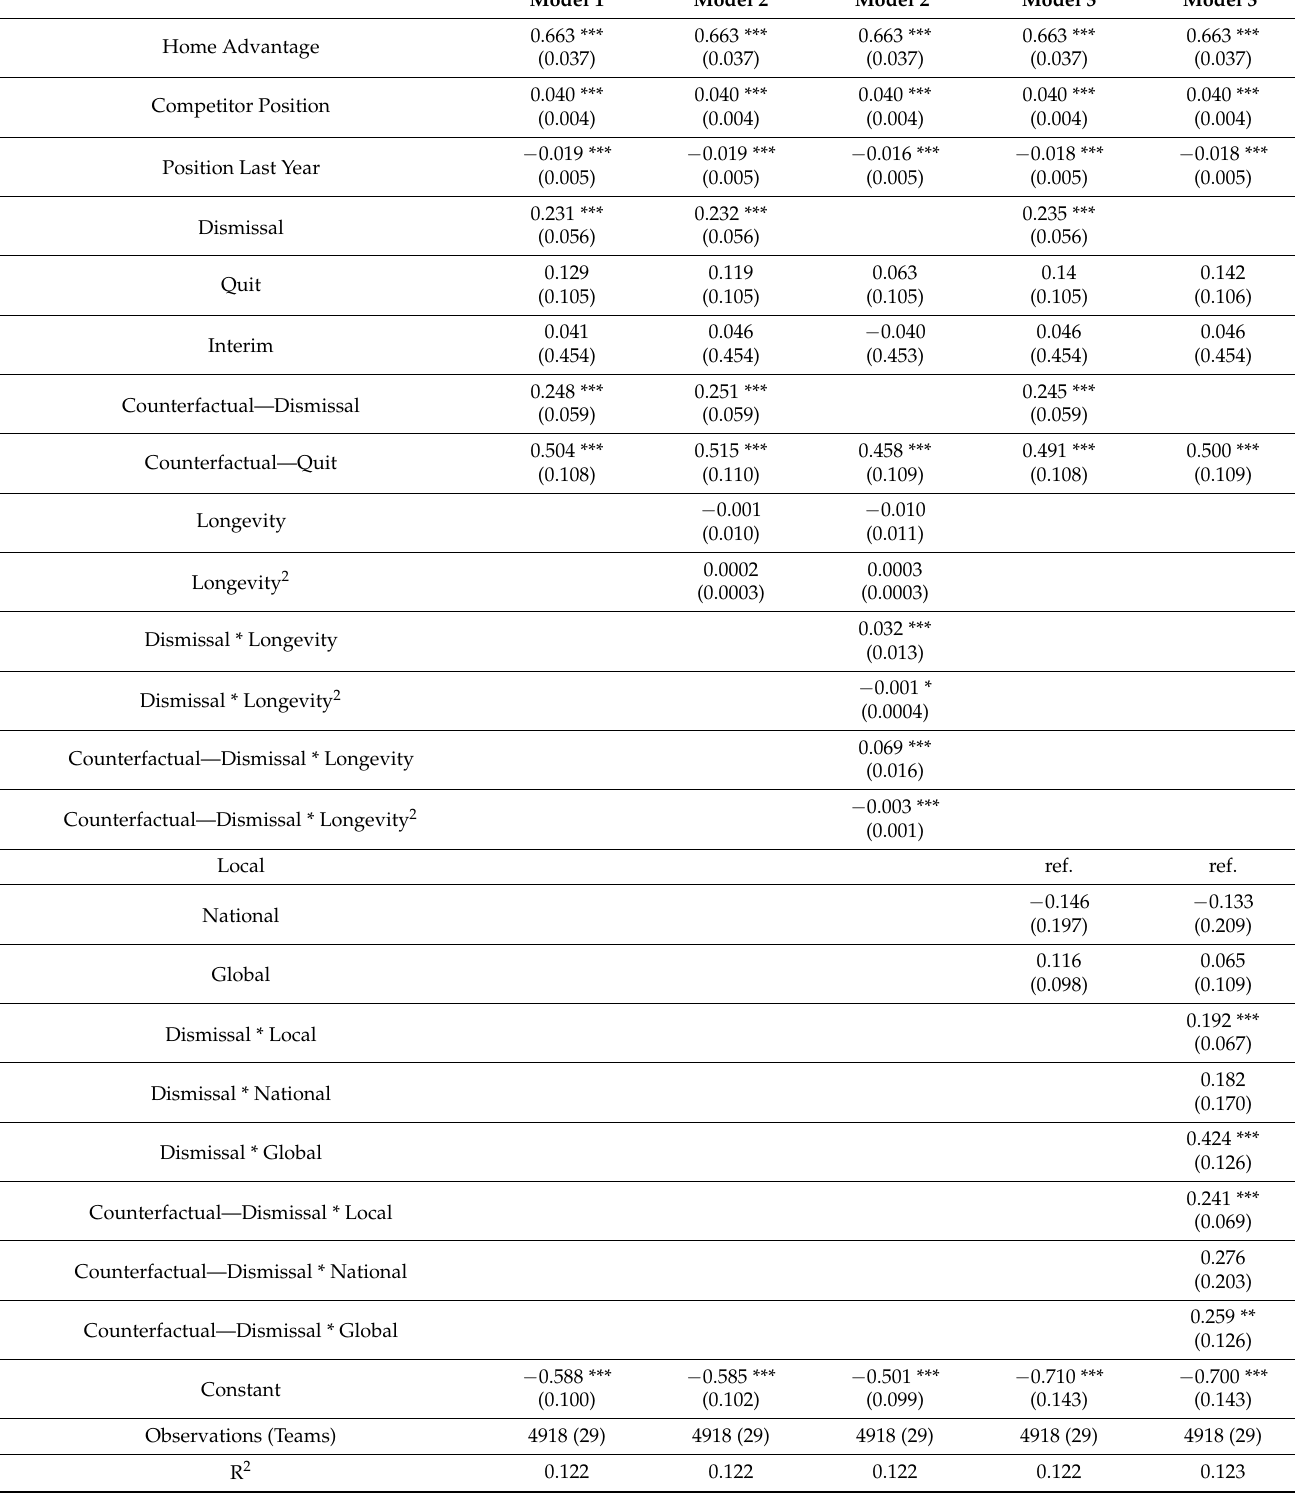
Table 2. Results of the team fixed effect regressions (dependent variable: goal